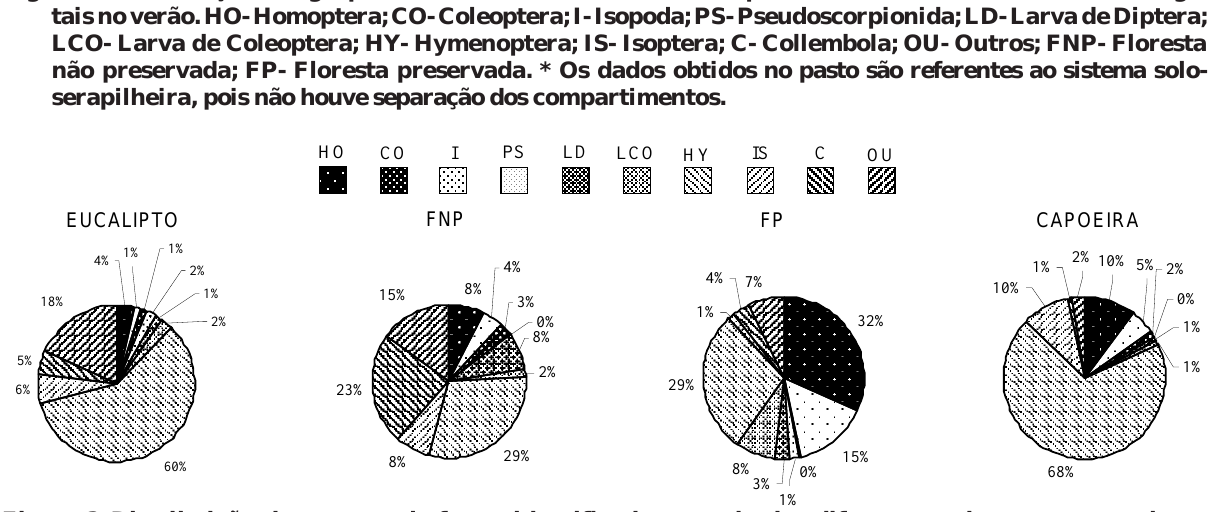
Figura 2. Distribuição dos grupos de fauna identificados no solo das diferentes coberturas vegetais no verão. HO- Homoptera; CO- Coleoptera; I- Isopoda; PS- Pseudoscorpionida; LD- Larva de Diptera; LCO- Larva de Coleoptera; HY- Hymenoptera; IS- Isoptera; C- Collembola; OU- Outros; FNP- Floresta não preservada; FP- Floresta preservada. * Os dados obtidos no pasto são referentes ao sistema solo- serapilheira, pois não houve separação dos